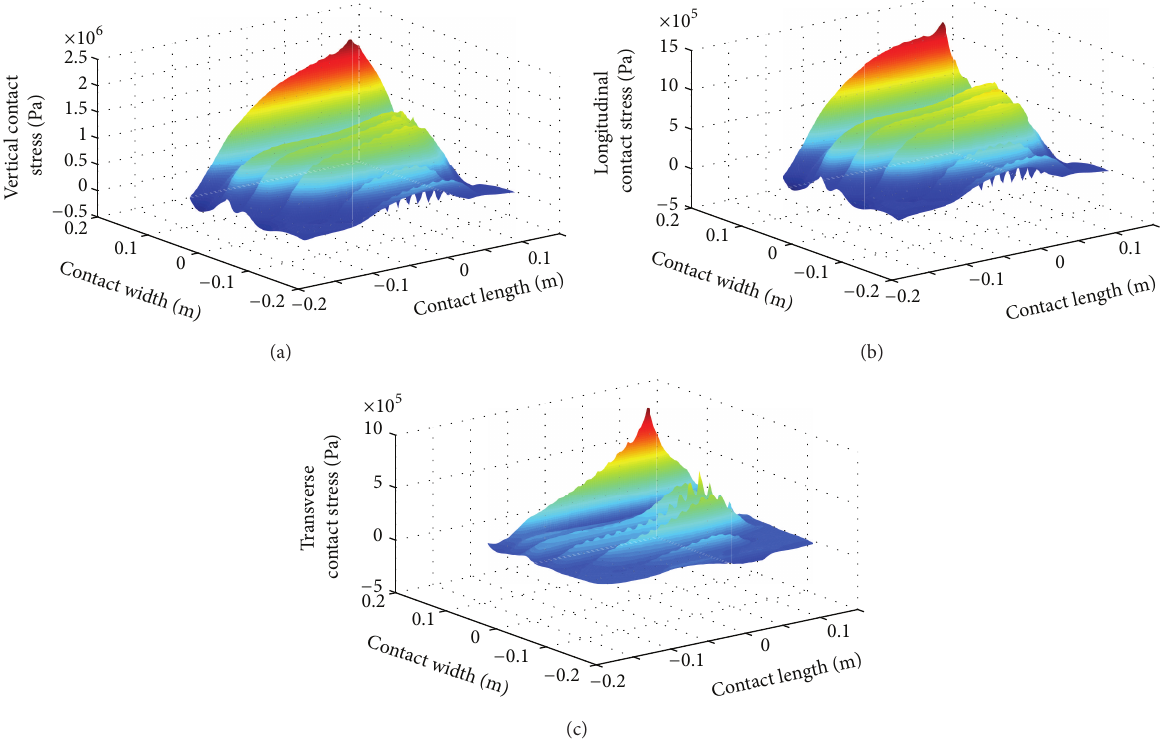
Figure 17: Contact stress distribution under braking condition combined with camber and